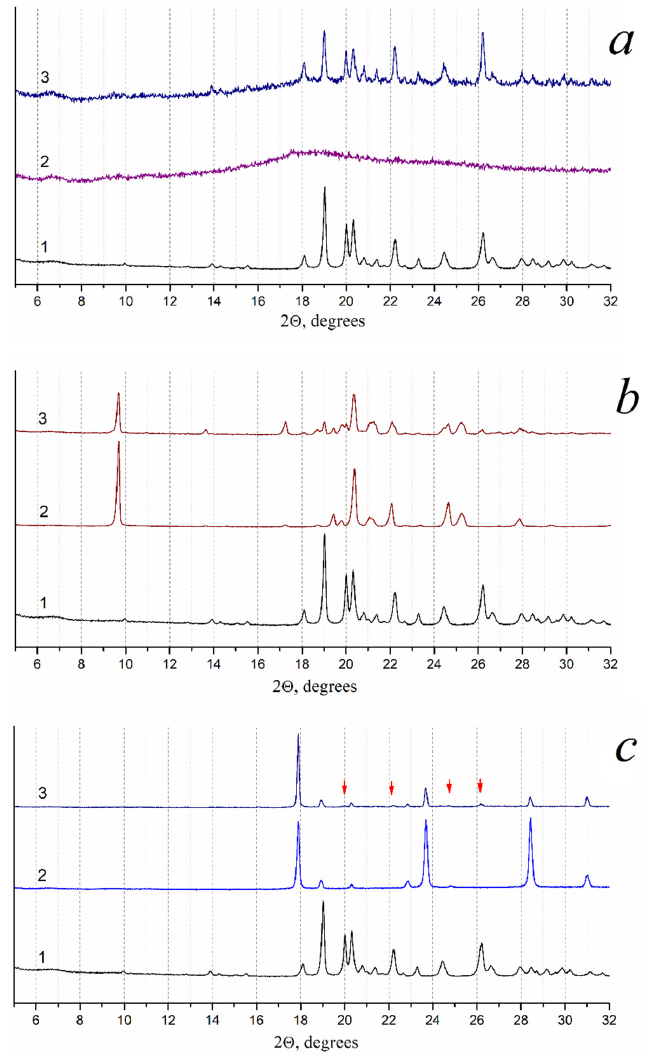
Figure 5. X-ray powder diffraction patterns: ( a ) ultrafine Pz obtained by TFF + FD (1), Pz formulation with trehalose (3) and the trehalose sample obtained under identical conditions as formulations (2); ( b ) ultrafine Pz obtained by TFF + FD (1), Pz formulation with mannitol (3) and mannitol sample, obtained under identical conditions as formulations (2); ( c ) ultrafine Pz, obtained by TFF + FD (1), Pz formulation with glycine (3) and β -glycine, obtained under identical conditions as formulations (2). The strongest reflections of Pz in the Pz formulation with glycine are pointed out by red